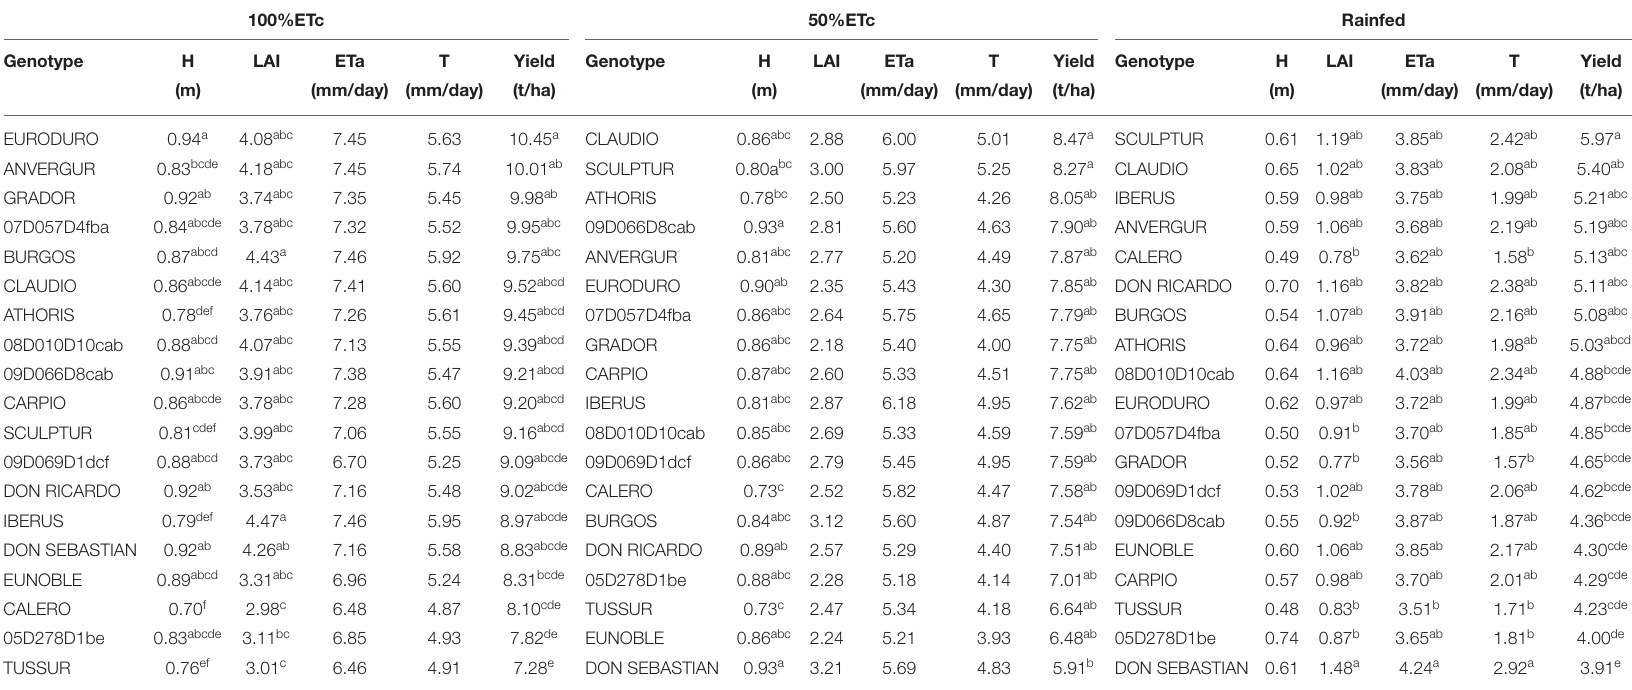
TABLE 6 | Comparison of estimated plant height (H), leaf area index (LAI), actual evapotranspiration (ETa), actual transpiration (T), and yield in each genotype on May 22nd (grain